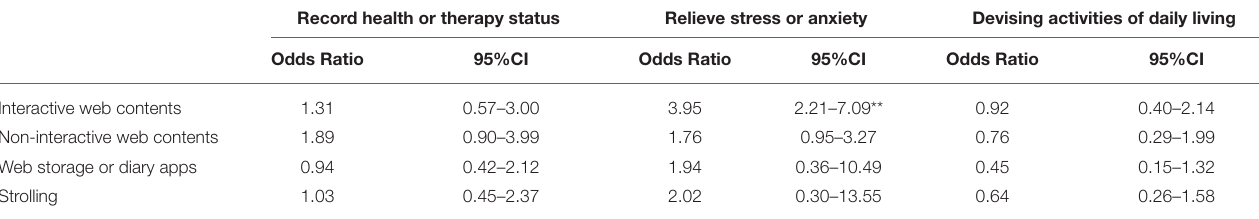
TABLE 3 | Odds Ratio of satisfactions for web